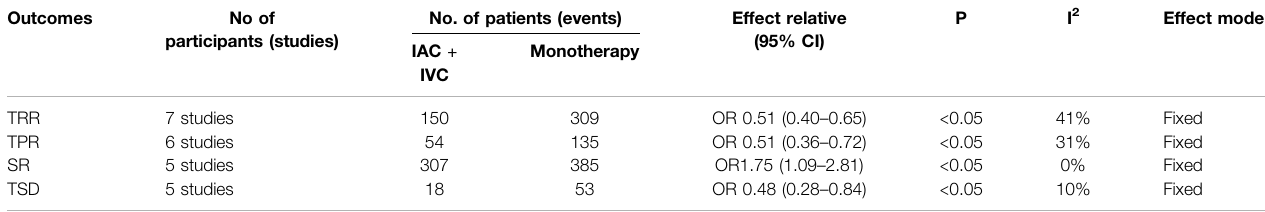
TABLE 2 | Summary of therapeutic ef fi cacy and survival outcomes.